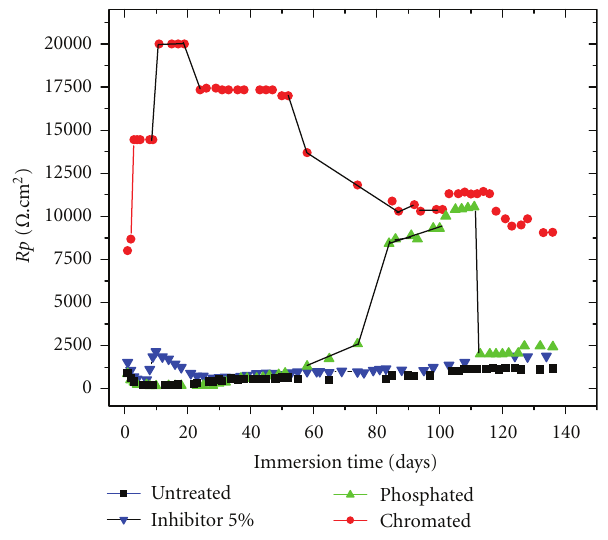
Figure 4: Evolution of Rp of galvanized steel with the exposure time with various surface conditions immersed in a 0.5M NaCl solution.